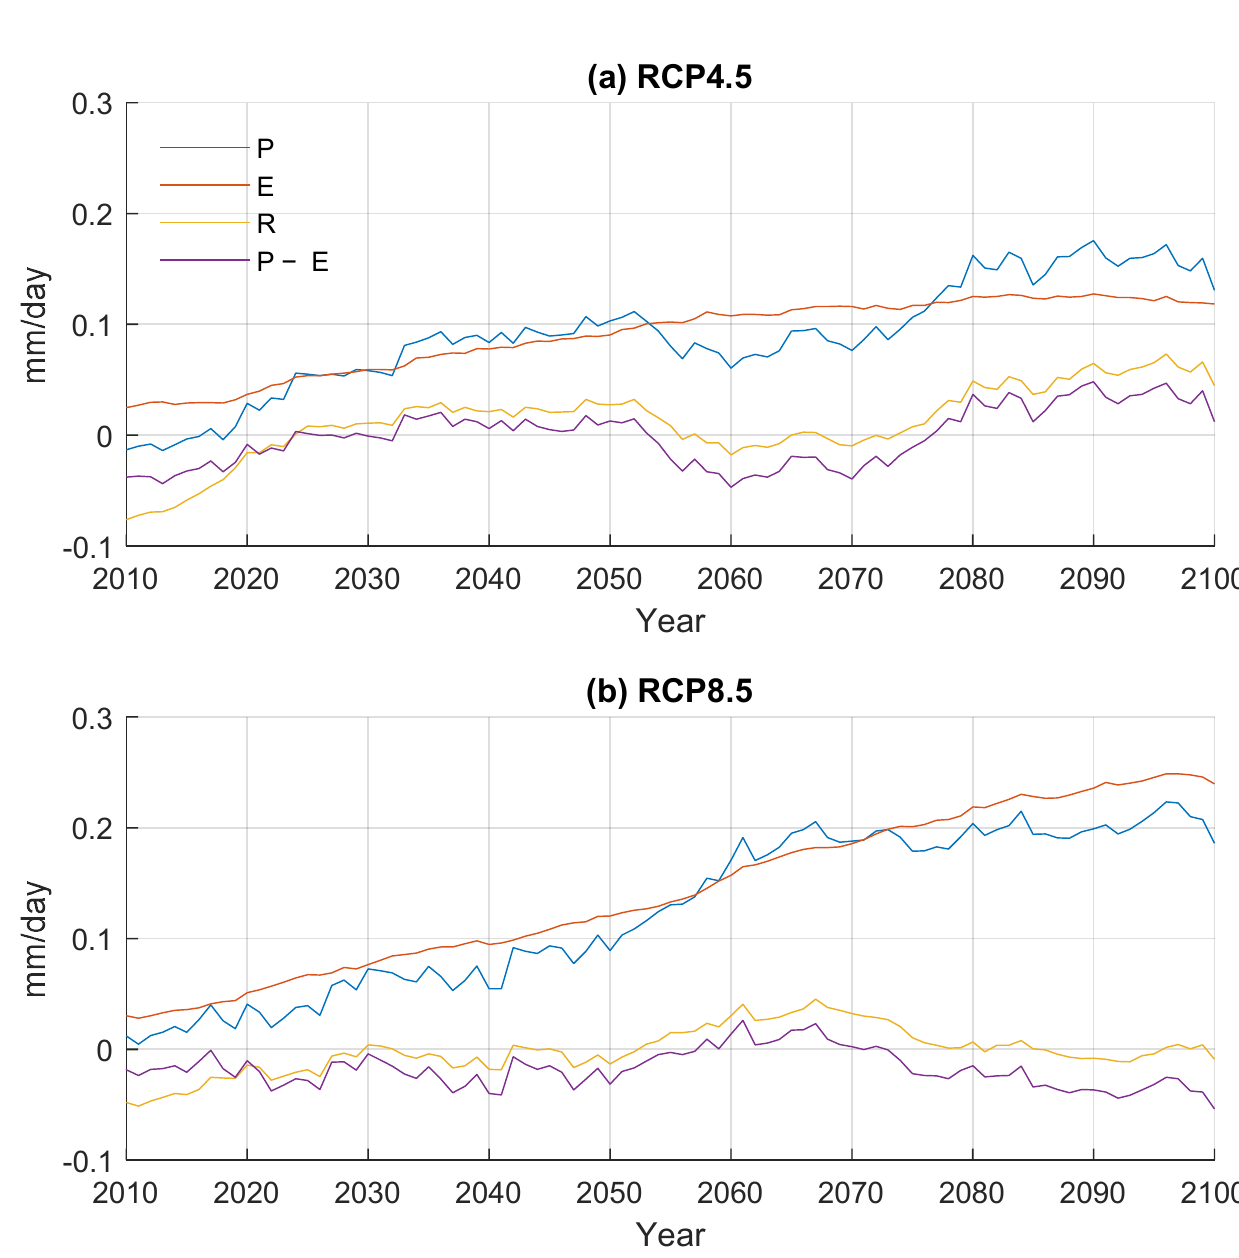
Figure 7. Projected domain average anomalies of precipitation, evapotranspiration, and runoff. The time series are smoothed with a 20-year moving average filter. Table 2. Future trends (mm/day per decade) of domain average precipitation, evapotranspiration, and runoff (P, E, and R denote precipitation, evapotranspiration, and runoff, respectively).